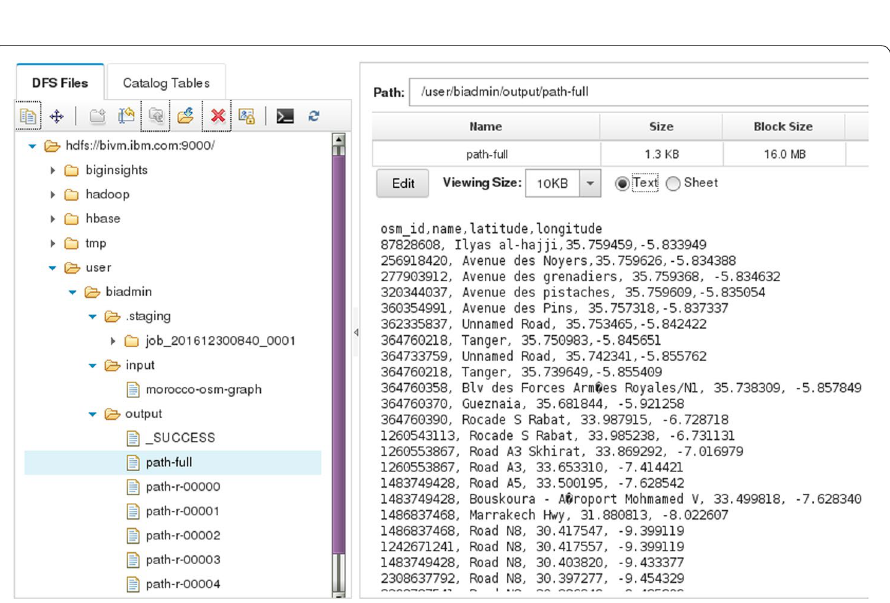
Fig. 9 Reduce stage: concatenation of partial paths. The set of intermediate paths are merged to build the full path